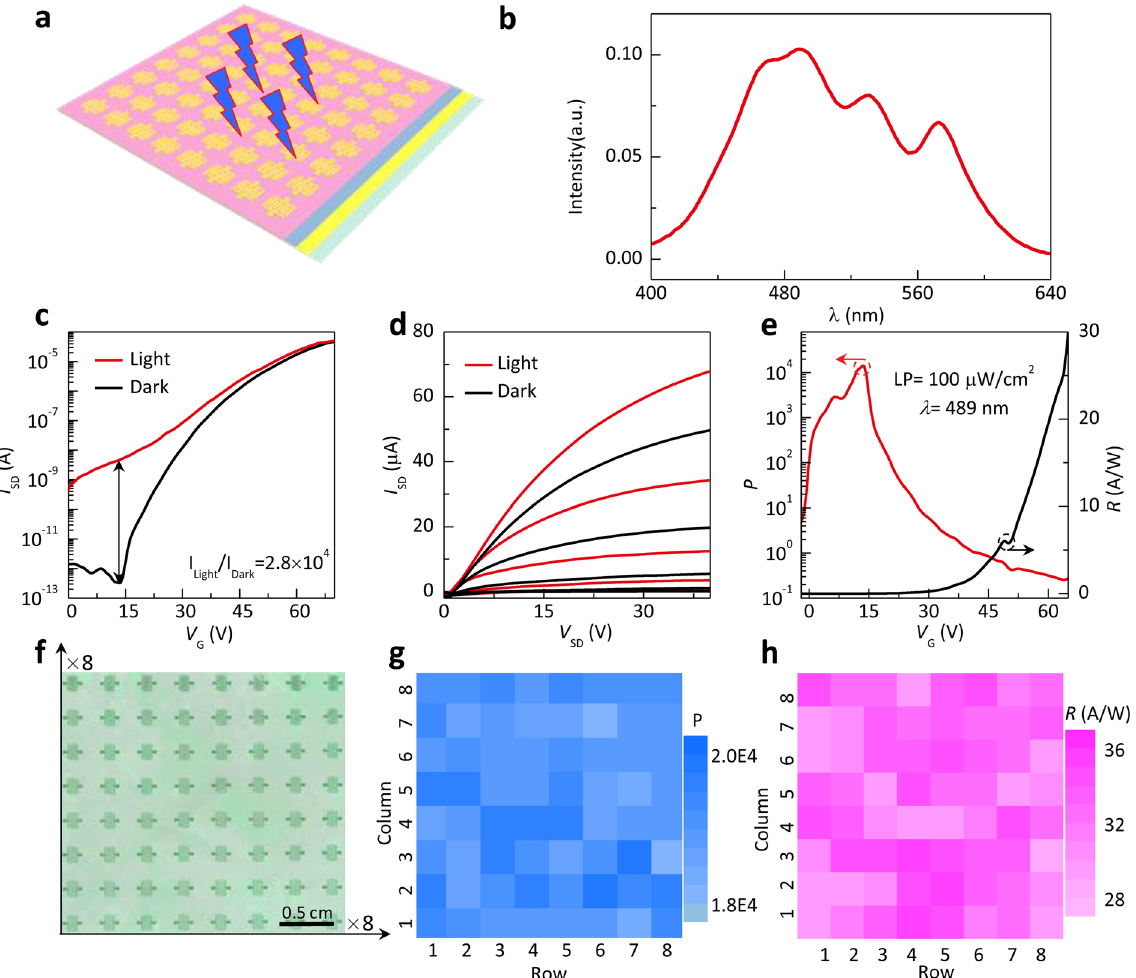
Figure 3. Optoelectronic properties of the PTCDI-C 13 H 27 thin-film phototransistor. ( a ) Schematic image of the transistor under illumination. ( b ) Absorption spectra of the PTCDI-C 13 H 27 . ( c , d ) Typical transfer and output characteristics of the PTCDI-C 13 H 27 thin-film phototransistor measured in the dark and under monochromatic light irradiation (wavelength: 489 nm, light power density: 100 μ W cm − 2 ). ( e ) R and P as a function of V G . ( f ) Photograph of the 8 × 8 PTCDI-C 13 H 27 thin-film phototransistor array. ( g , h ) R and P mapping of the phototransistor